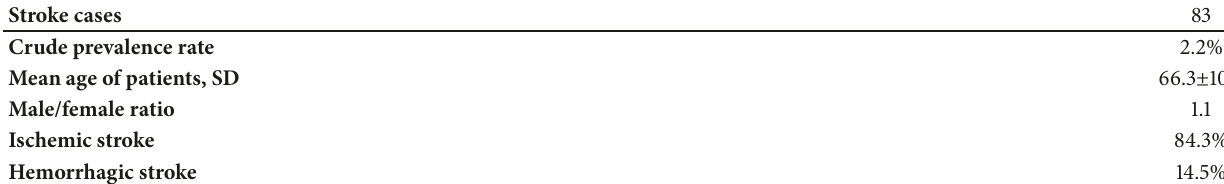
Table 2: Demographic and clinical characteristics of stroke